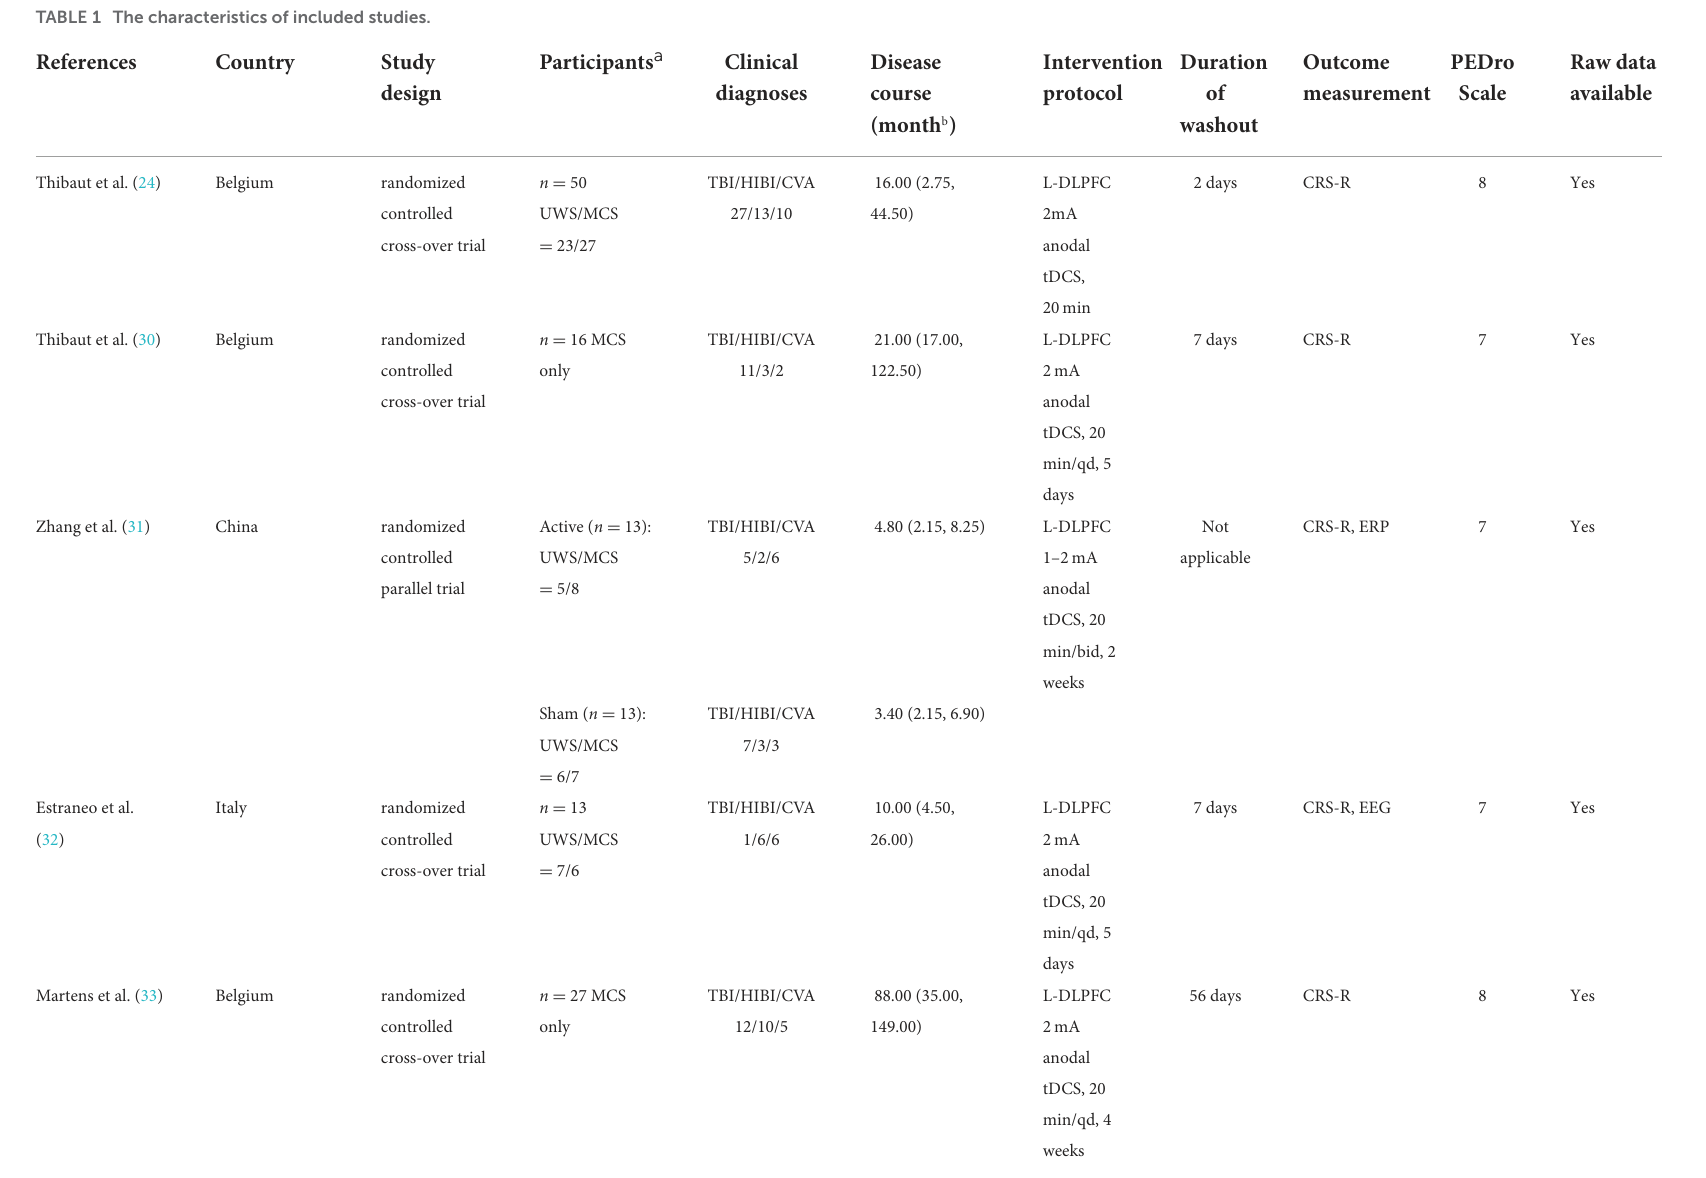
TABLE 1 The characteristics of included